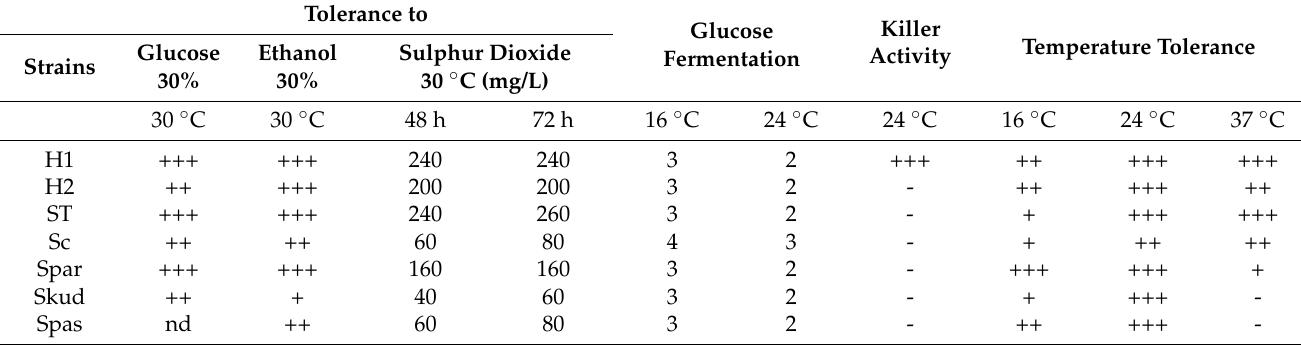
Table 3. Oenological characterization of investigated strains in the presence of 30% glucose and 30% ethanol, sulphur dioxide tolerance after 48 and 72 h, temperature tolerance at 5 ◦ C, 16 ◦ C, 24 ◦ C and 37 ◦ C, glucose fermentation ability was determined at two different temperatures (16 ◦ C, 24 ◦ C). Killer activity was monitored at 24 ◦ C. Tolerance to